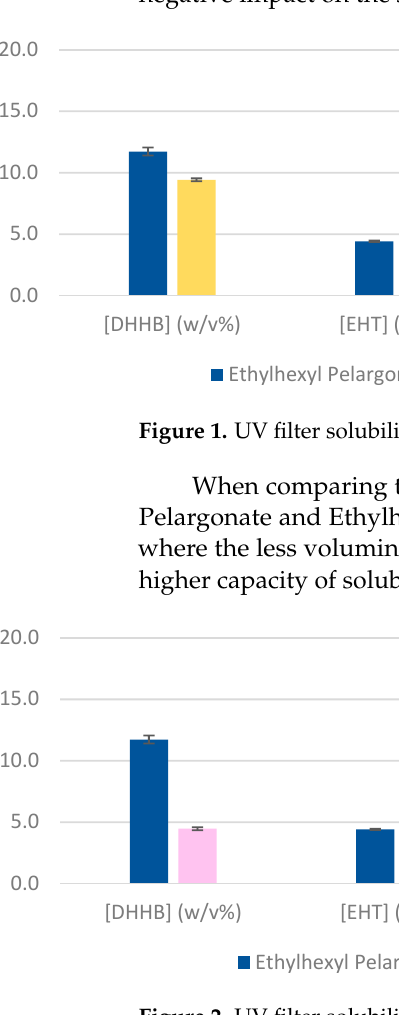
Figure 2. UV filter solubility of Ethylhexyl Pelargonate versus Ethylhexyl Stearate .